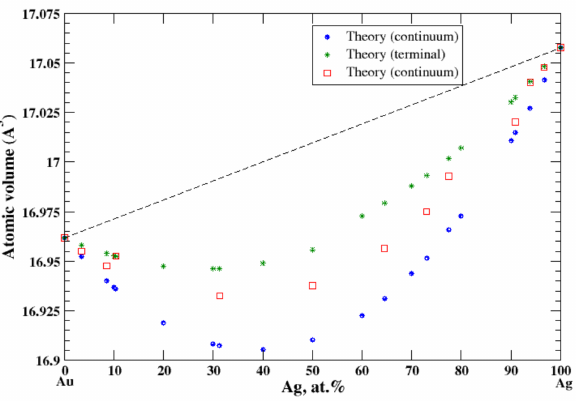
Figure 15. Atomic volume vs. concentration for Ag-Au alloy system. The experimental data are from Ref. [16] (p. 267 and p.